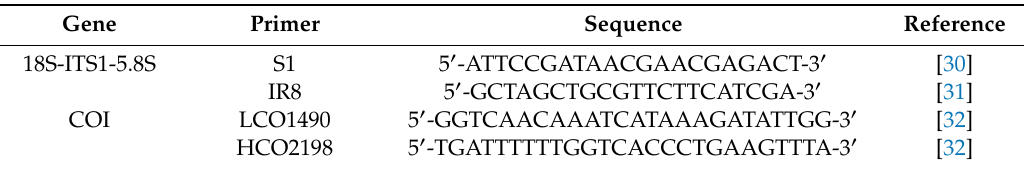
Table 1. Primers used for amplification and sequencing.